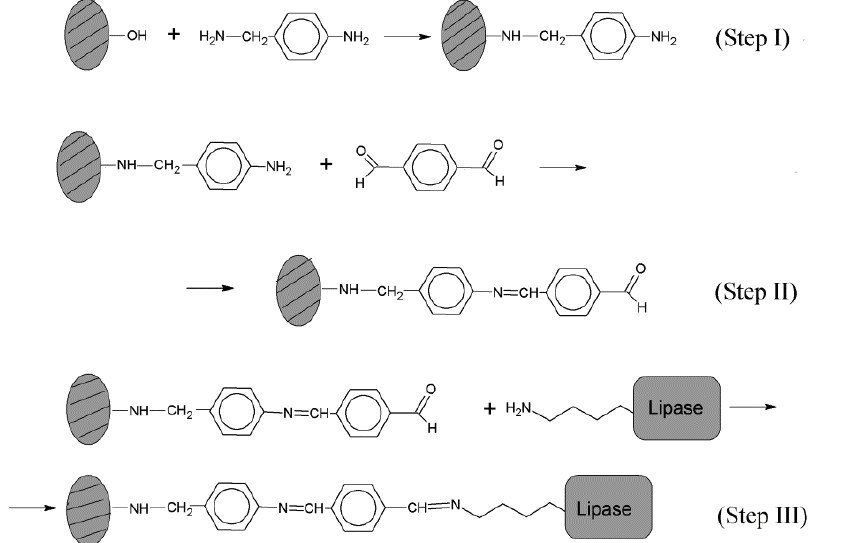
Figure 2. General scheme of the immobilization of Rhizopus oryzae lipase (ROL) through the ε -amino group of lysine residues to an organic linker bonded to the inorganic support.